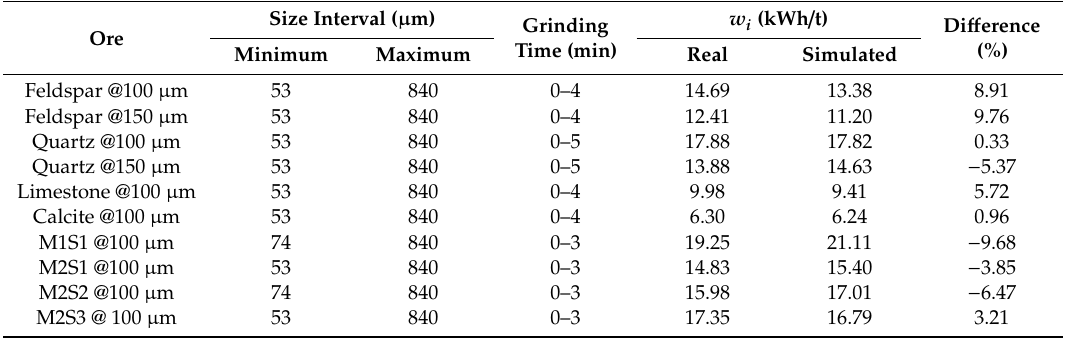
Table 4. Compared results between w i and w is using the simplified procedure to obtain the kinetic